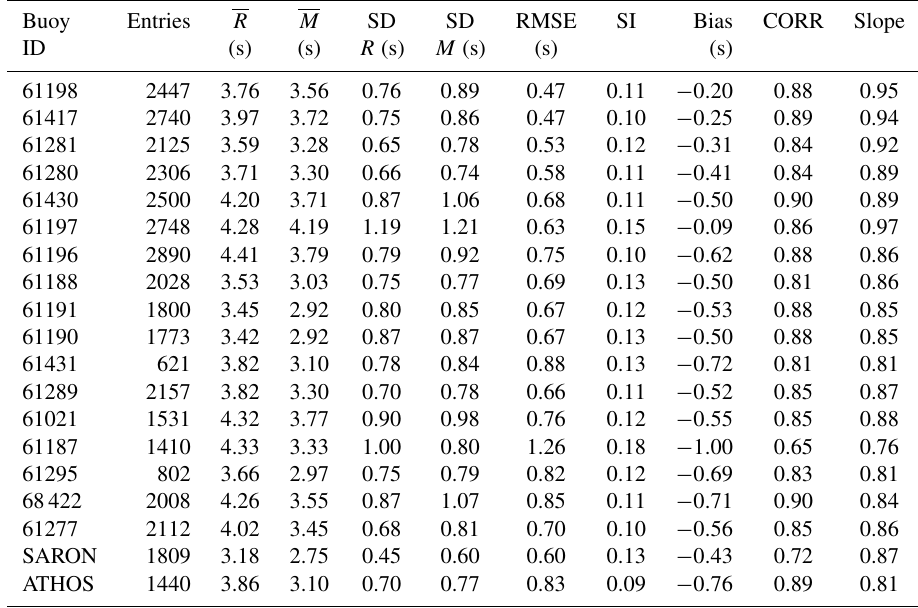
Table 7. Med-waves T m evaluation against wave buoy T m , for each individual buoy location, for a 1-year period (2014).